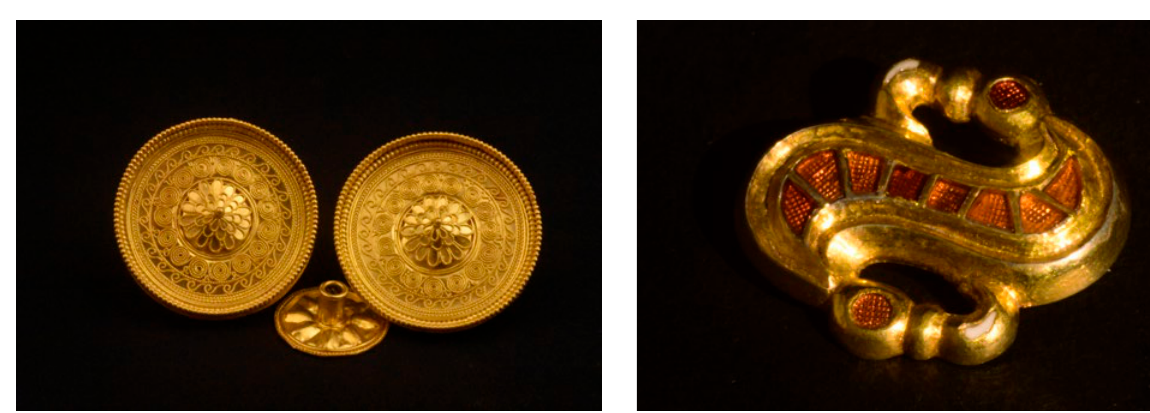
Figure 1. 22 kt gold classic Greek style earrings, diameter 2.5 cm. Technique: filigree. Author: Alessandro Pacini.